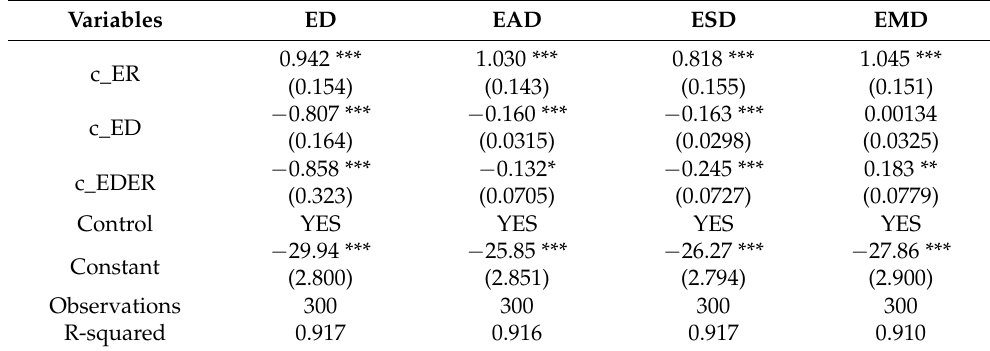
Table 4. Regression results for moderating effects.